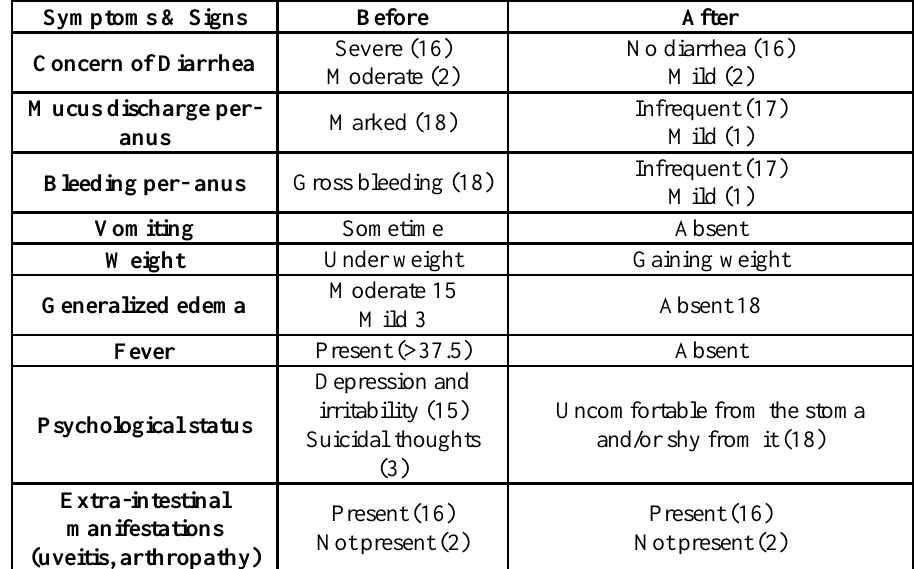
Figure 8 and table 3showed the distribution of studied patients according to their total serum protein levels at preoperative and at the last day of follow up postoperatively. All patients got hypoproteinemia preoperatively (TSP <2 g/dl, mean=1.57±0.2g/dl) while all patients serum protein was improved at last measurement (TSP>3.1g/dl, mean= 3.92±0.54g/dl). Paired sample t-test showed that statistically significant Table (4): Changing in clinical features before and after